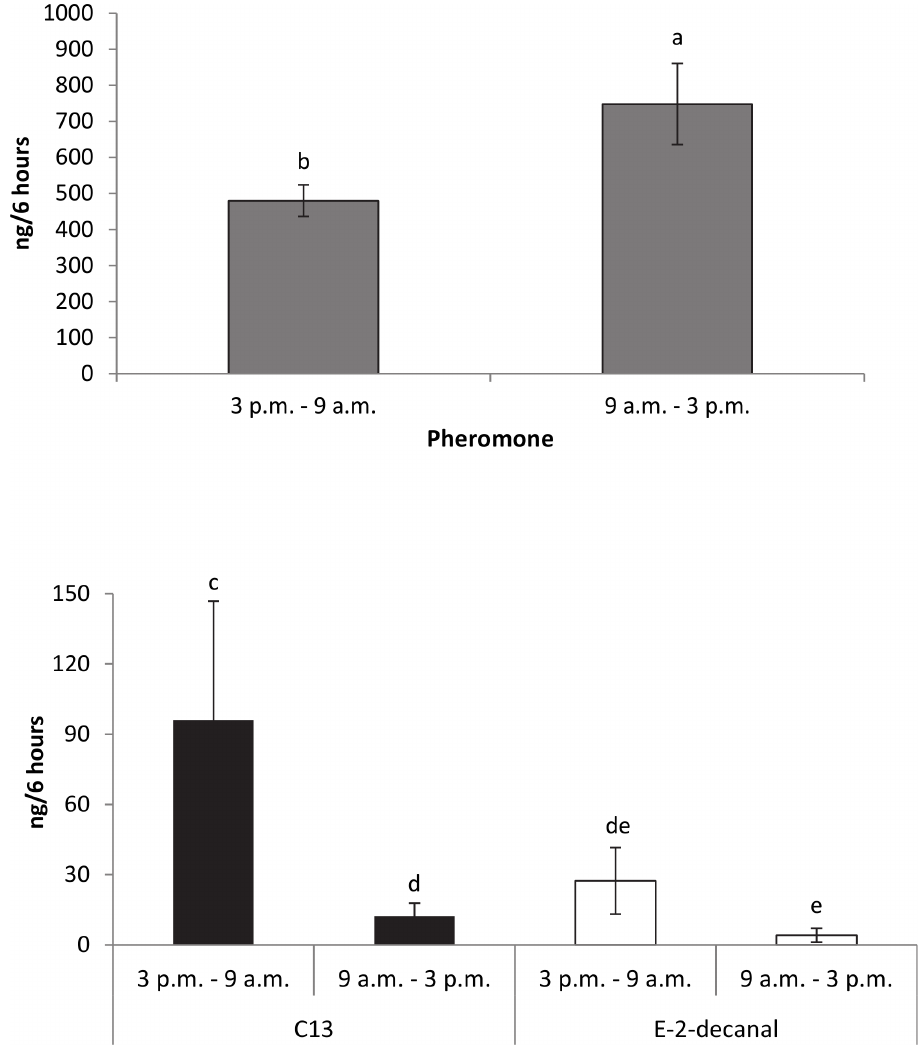
Fig 3. Average amount of pheromone, C13, and E -2-decenal in AM and PM collections, standardized by # of hours. Single male H . halys release more pheromone in the morning/early afternoon than in the evening/overnight, while C13 was released in greater amounts in the evening/overnight. ANOVA: Log (Compound) = Time of day. For pheromone, F 1,209 − 35.368, p < 0.0001; C13, F 1,209 − 5.991, p = 0.0152; E - 2-decenal, F 1,209 − 2.919, p = 0.089. For whole model: Log (Compound) = Time of day, Compound, Time of day * Compound, F 5,629 − 151.061, p < 0.0001; Time of day F-34.531, p < 0.0001; Compound F-350.496, p < 0.0001; Time of day * Compound F-8.392, p = 0.001 (n = 7 males, 210 time periods).